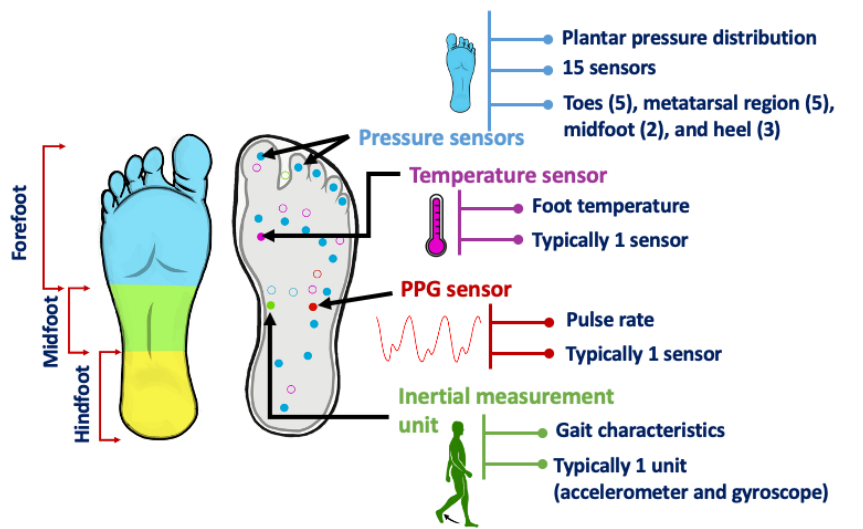
Figure 9. Proposed locations for sensors measuring various parameters in an insole-based monitoring system. Filled shapes indicate ideal sensor locations; hollow circles indicate alternative or additional sensor locations.